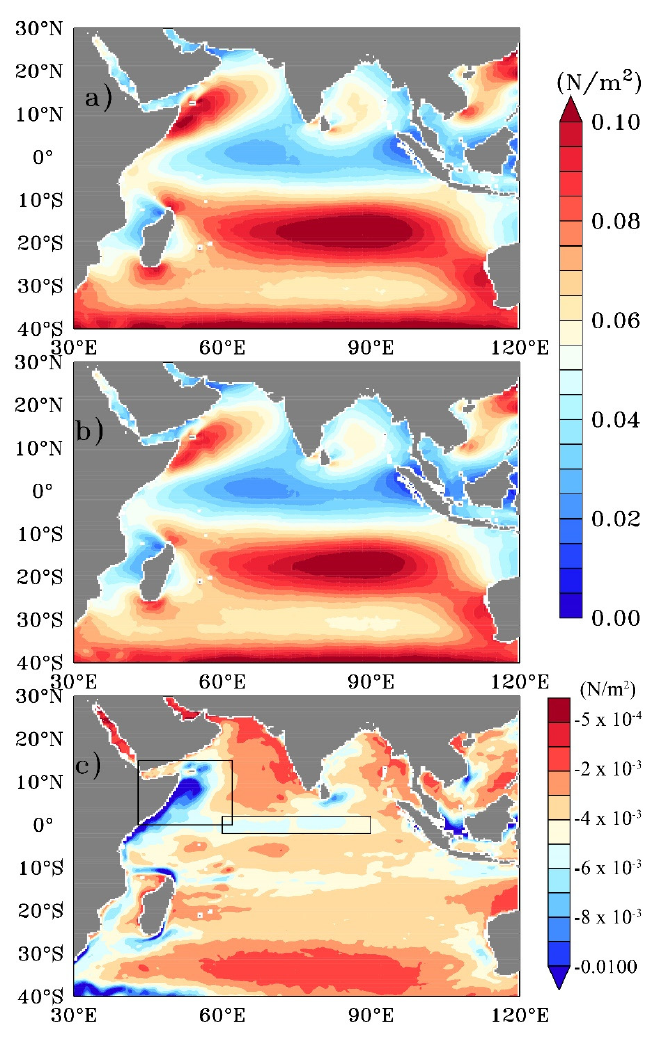
Figure 1. Wind stress (N/m 2 ) estimated ( a ) without currents, ( b ) with currents, and ( c ) difference between the two wind stresses ( a , b ). The regions off Somali Coast and equatorial Indian Ocean are shown as boxes in Figure ( c ).